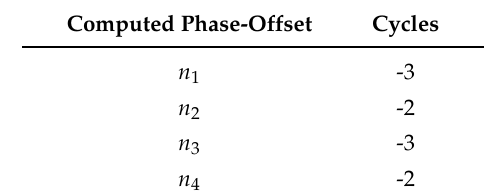
Table 2. Phase-offset corrections for artificially disconnected regions.